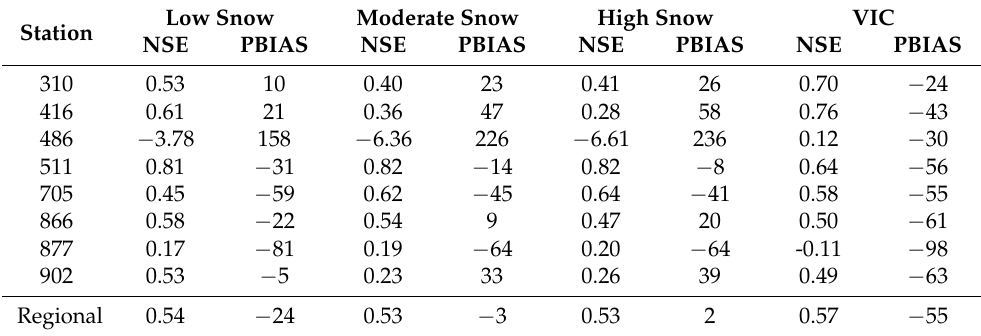
Table 4. Performance statistics for gridded daily SWE simulations using high, moderate, and low snow parameter set models developed in this study for each grid cell containing a SNOTEL station and SWE simulations using Variable Infiltration Capacity (VIC) model. All simulations forced with data from [34]. Comparisons conducted over the SNOTEL station period of record, start dates 1993–1997 through end of water year 2016. Performance statistics labeled ‘Regional’ pooled all station data 1